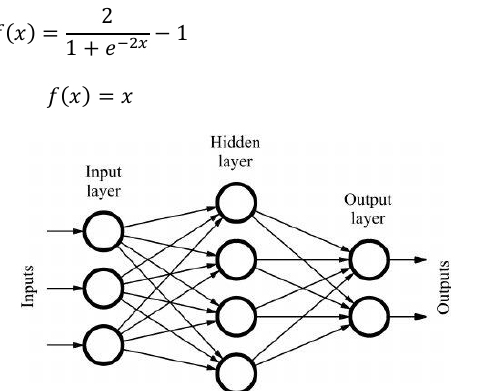
Figure 5. An example of a three-layer artificial neural network structure